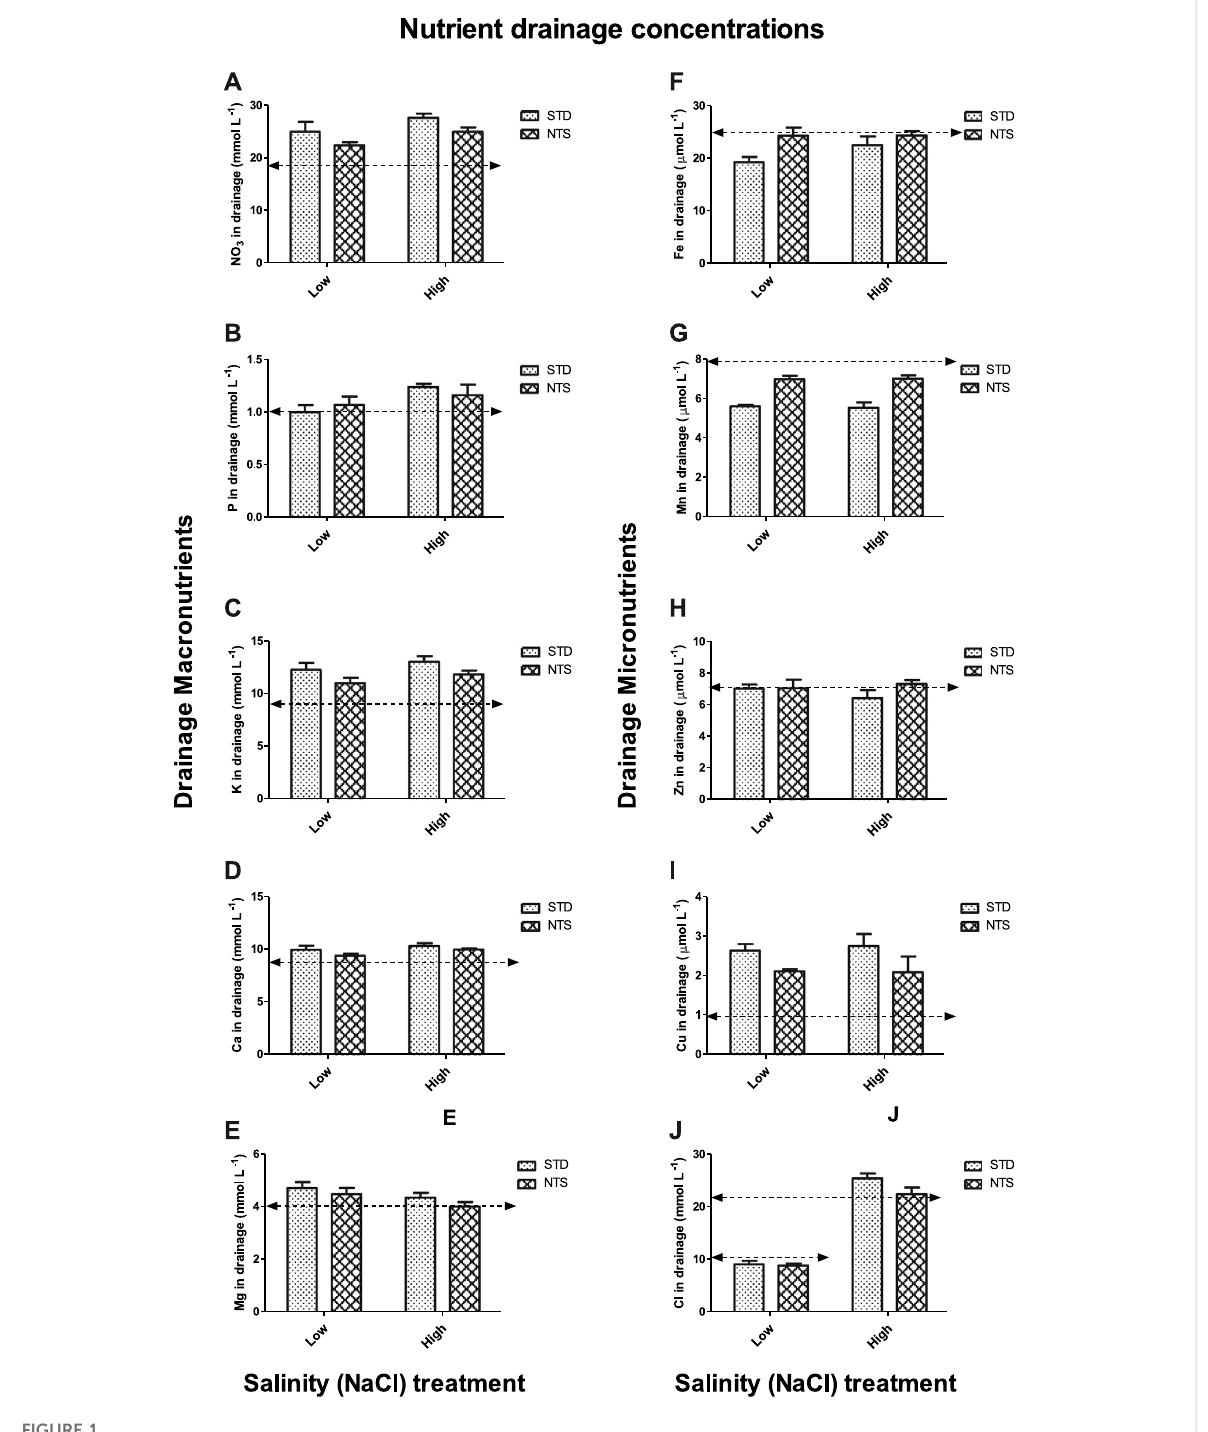
FIGURE 1 Nutrient drainage concentrations of macronutrients (A – E) (NO 3 , P, K, Ca, and Mg) and micronutrients (F – J) (Fe, Mn, Zn, Cu, and Cl) in hydroponic tomato crops supplied with nutrient solution compositions provided by two nutritional strategies (i.e., standard-STD and NUTRISENSE- NTS)underlow-andhigh-salinity(NaCl)levels. “ STD ” correspondstoatypicalreplenishmentstrategyinwhichwaterandnutrientswereaddedinthe system based on predetermined nutrient to water uptake ratios termed nutrient uptake concentrations-UCs and “ NTS ” corresponds to an alternative replenishment strategy in which, water and nutrients were added in the system based on readjustments of target nutrient UCs. Salinity (NaCl) treatments were established by adding NaCl at appropriate amounts in the primary water containing 1.6 mM of NaCl (Low) to increase the NaClconcentrationto5.0 mM(High).Verticalcolumnsin fi gurepartsaremeansoffourreplicates±standarderrors.Dottedlinesembeddedin fi gure parts represent standard recommendations (based on Savvas and Gruda,